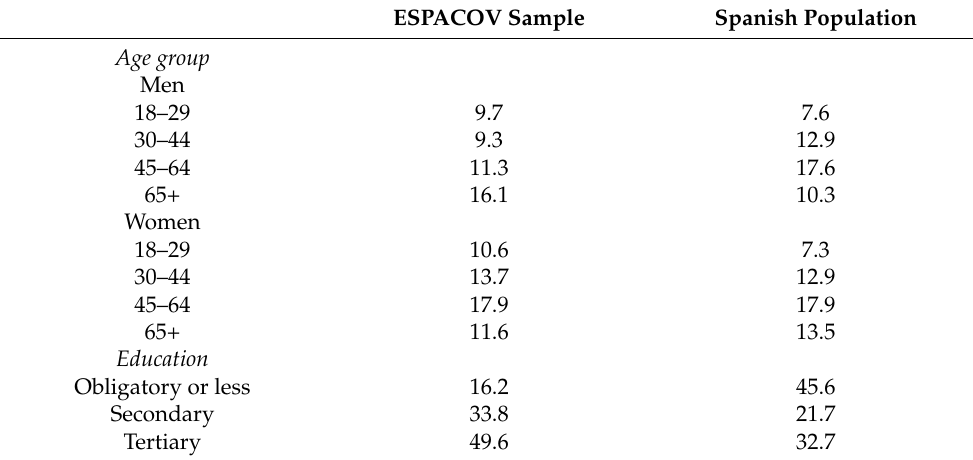
Table 5. Obtained sample distributions by sex and age group and by education level, and comparison with population parameters.